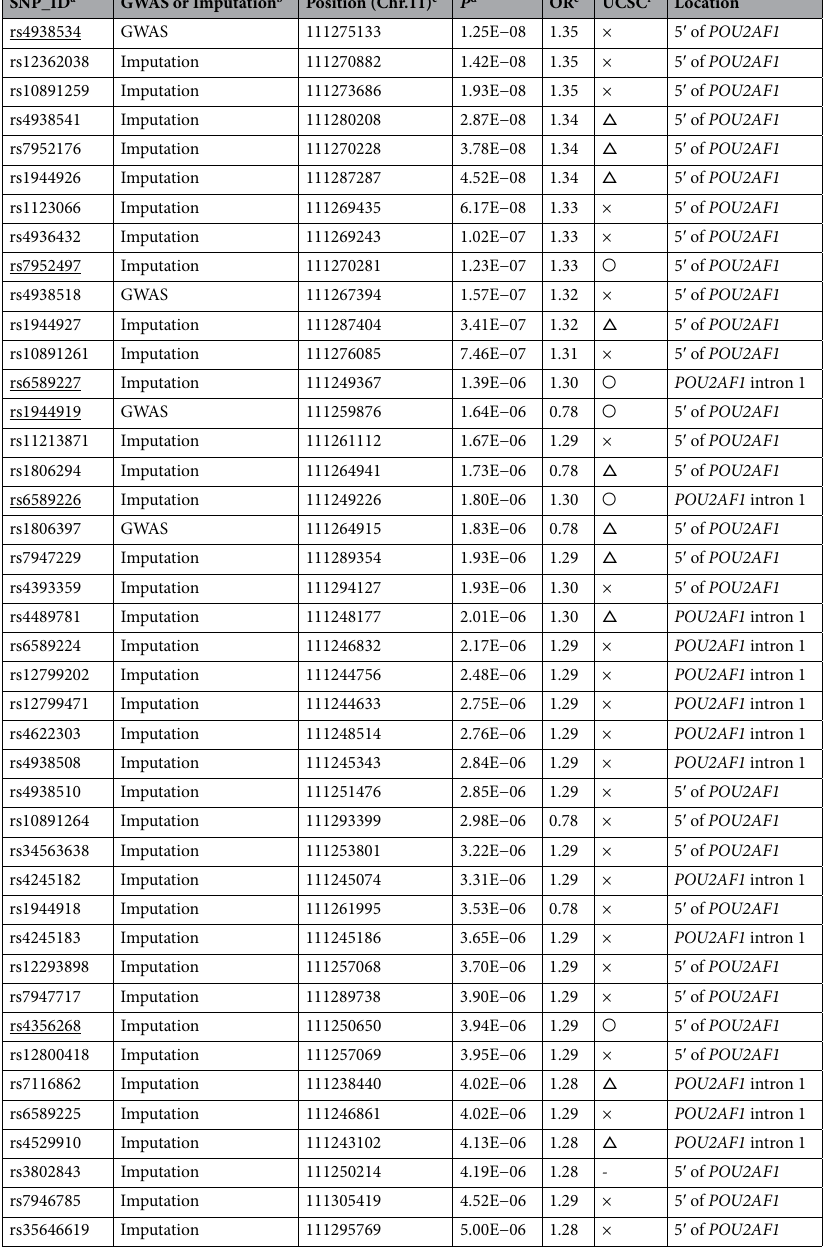
Table 1. SNPs associated with susceptibility to PBC in the Japanese population in chromosome 11q23.1 by high-density association mapping. a SNPs with underlines were the final candidate primary functional variants. b Genotyped by our previous GWAS (Kawashima M et al . 2017) or the imputed genotypes by the high-density association mapping in the present study. c Position of the SNPs in hg19. d P values calculated by Pearson’s Chi- square test for the allelic model. e Odds ratio (OR) of minor allele from the two-by-two allele frequency table. f Probability of the functional damages checked by UCSC genome